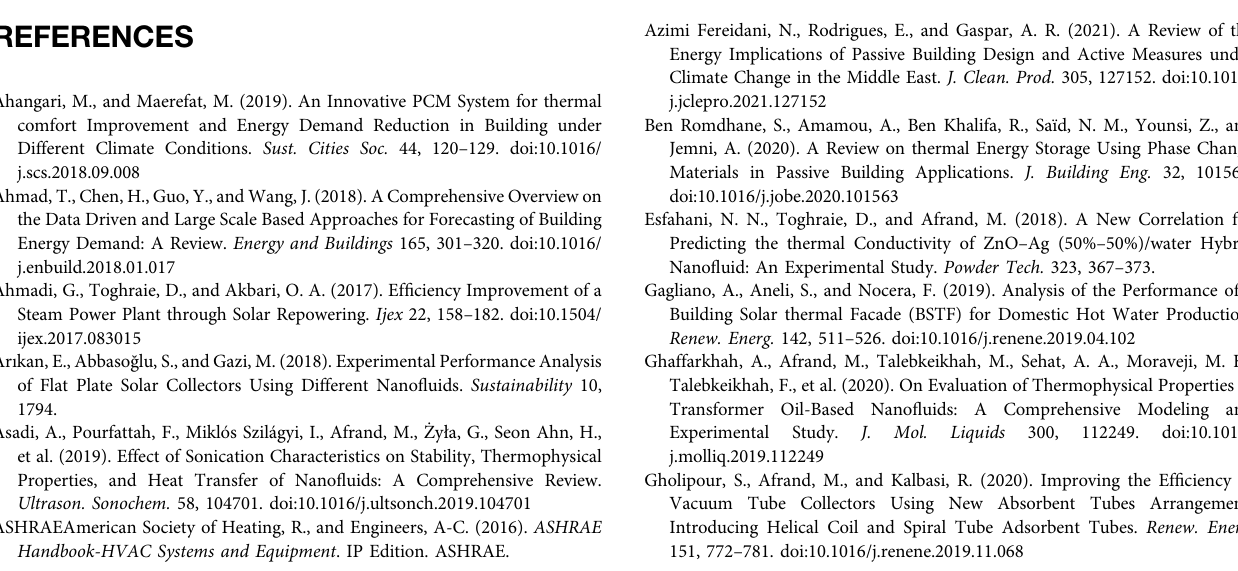
Figure 14 con fi rms this claim, nanoparticles of Al 2 O 3 improved energy-saving by 14.5%